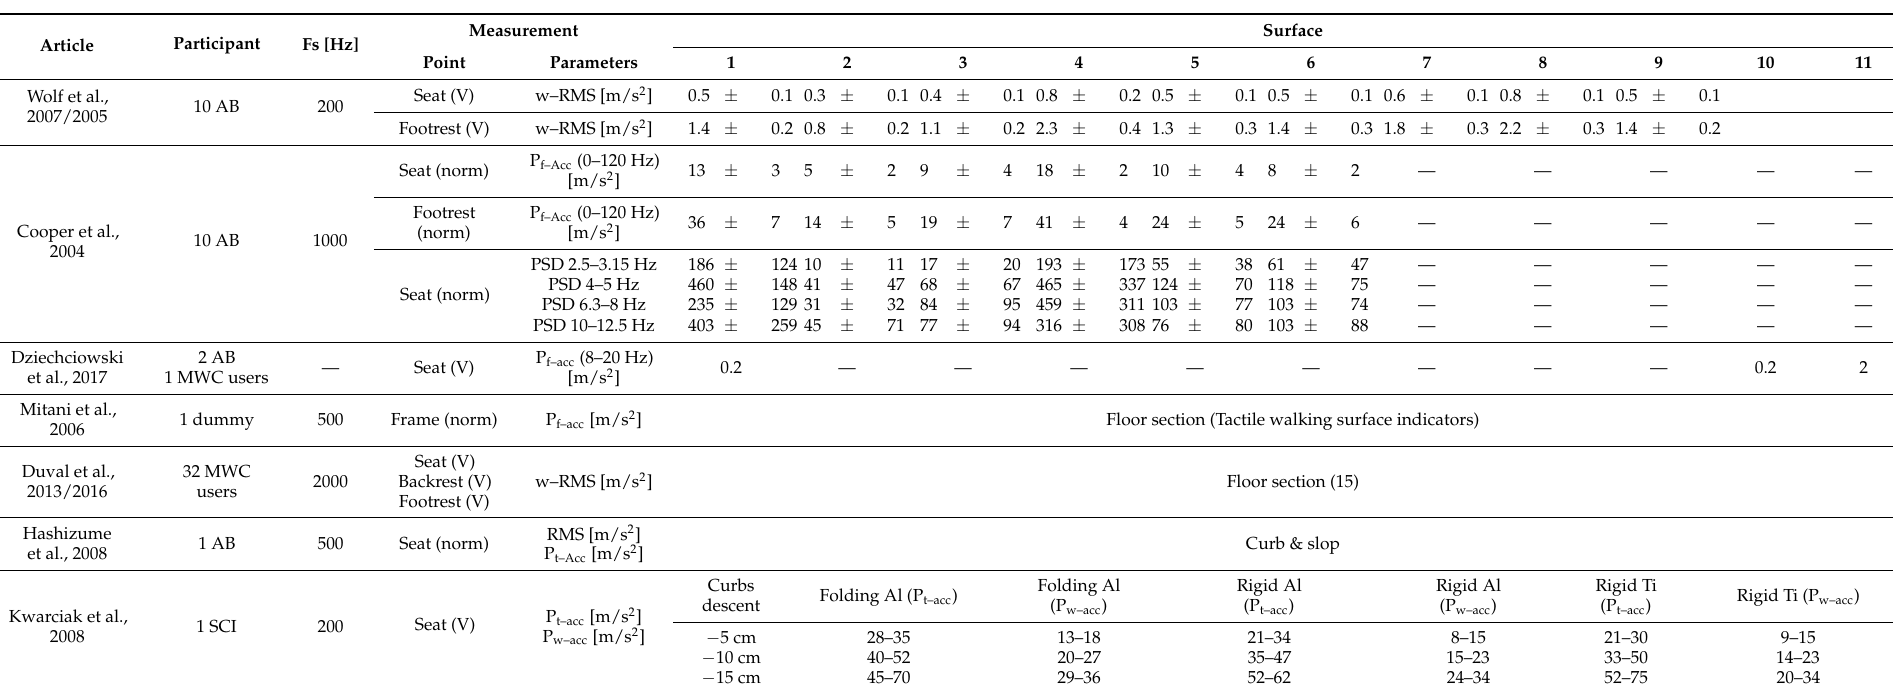
Table 6. Summary table of reviewed studies regarding the investigation of the effect of the floor